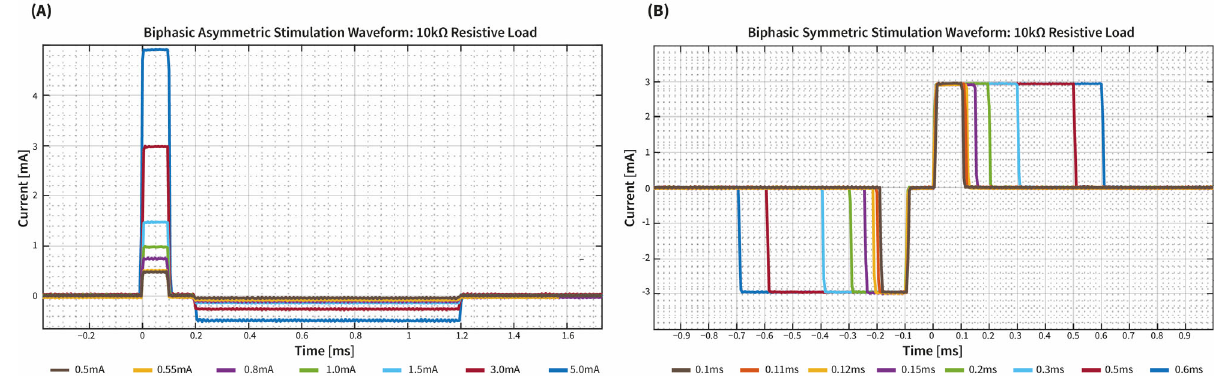
Figure 5. Waveform generation capability on 10 k Ω resistive load using ( A ) Biphasic asymmetric waveform with different amplitude and pulse width 100 μ s; ( B ) Biphasic symmetric waveform with different pulse width and amplitude 3 mA.